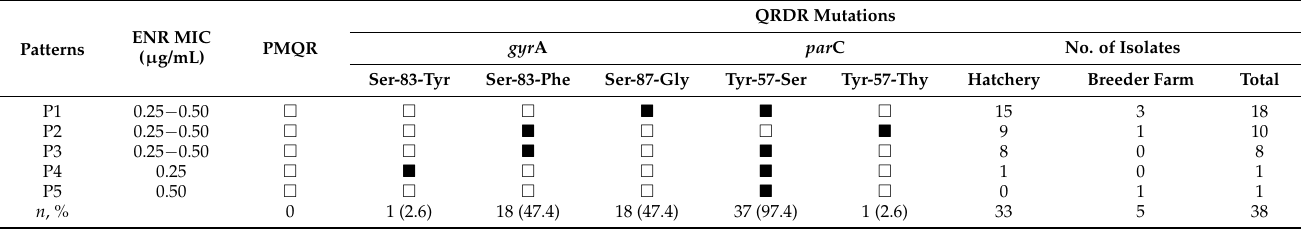
Table 4. Prevalence of plasmid-mediated quinolone resistance (PMQR) and quinolone-resistance determining region (QRDR) mutations among Salmonella (enrofloxacin (ENR), minimum inhibitory concentrations (MIC) ≥ 0.25) isolated from hatcheries and their upstream breeder